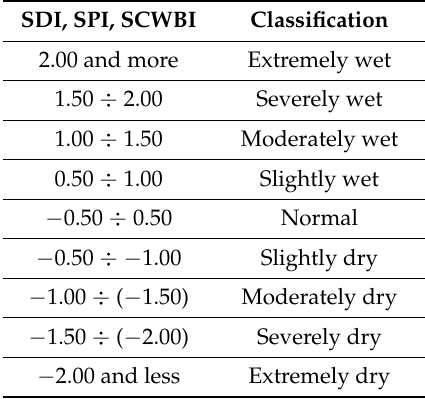
Table 3. Classification of Standardised: Discharge Index (SDI), Precipitation Index (SPI) and Climatic Water Balance Index (SCWBI) for months and years.